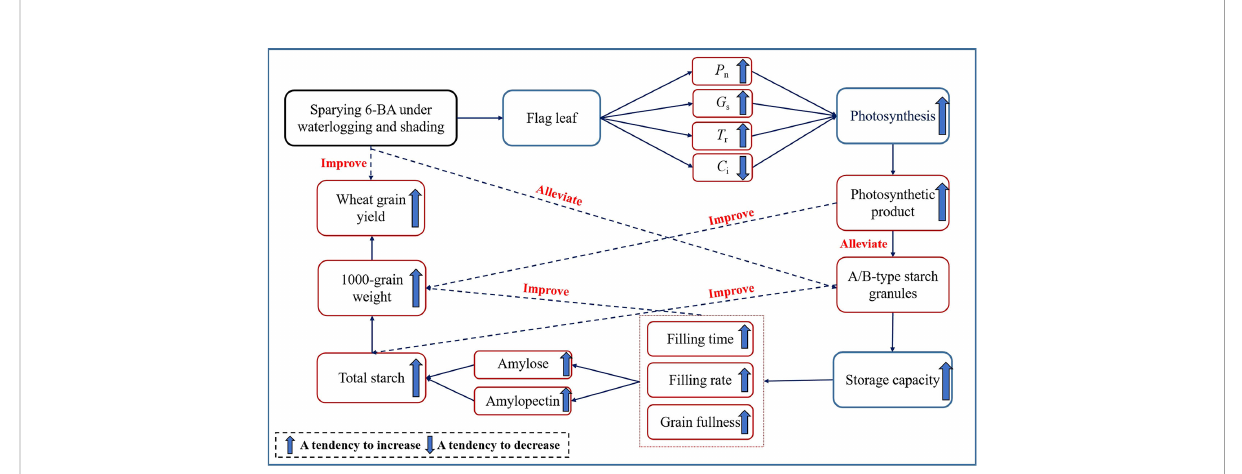
FIGURE 8 Analysis of the ways of spraying 6-BA to improve wheat yield under waterlogging and shading after